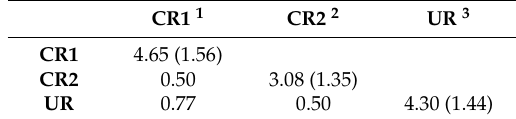
Table 3. Means, Standard Deviations and Correlations of the Risk Perception Variables (N =